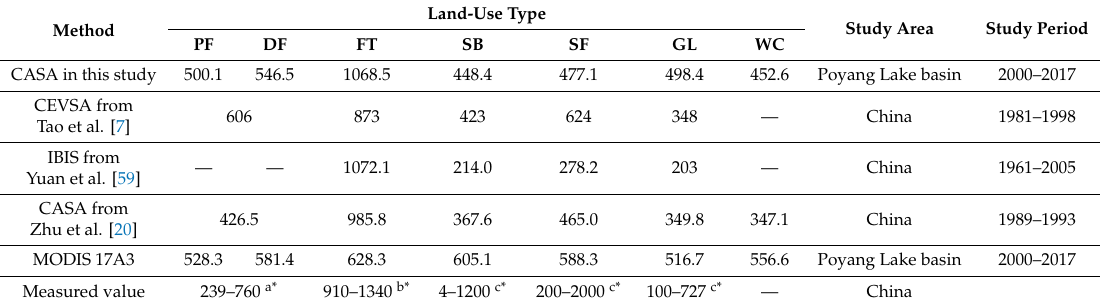
Table 3. Comparison of estimated net primary productivity (NPP) by di ff erent methods. (Unit: gC · m − 2 ).